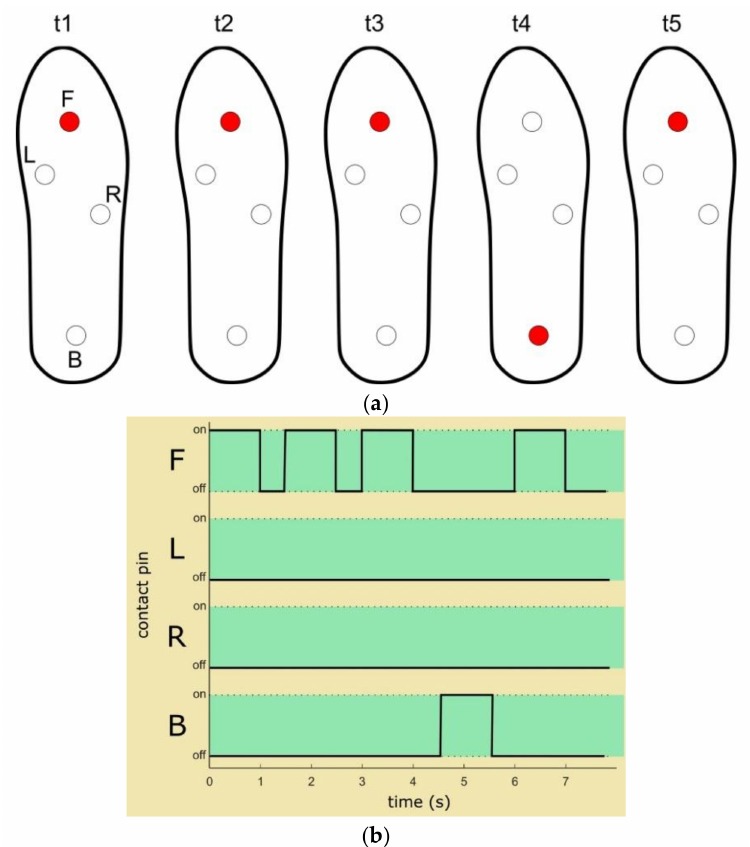
Figure 4. ( a ) Schedule of activation of the vibrating actuators for the direction recognition task—example for ‘forward’; ( b ) the corresponding vibrotactile pattern: the whole pattern is 7 s.